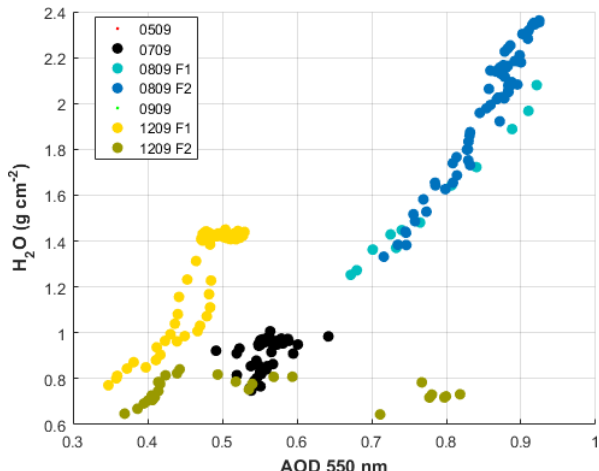
Figure 10. Column water vapour in a function of AOD at 550nm, both measured by the PLASMA2 sun photometer during the AEROCLO-sA